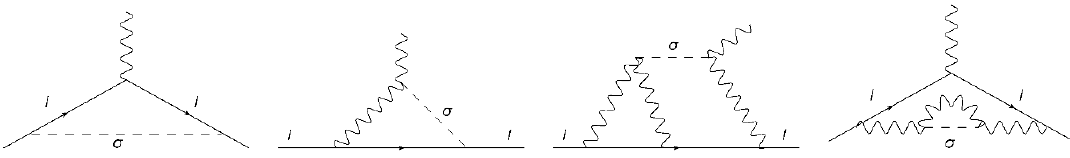
Figure 10. LO (leftmost diagram) and NLO radion contributions to the lepton anomalous mag- netic